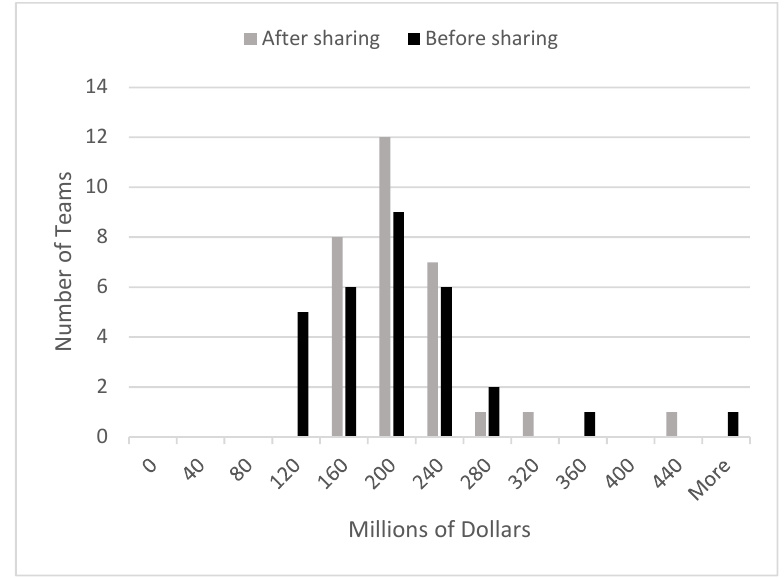
Figure 2. Local revenues pre and post-revenue sharing in MLB, 2011 season. ( R = $189.7 million, = 6234.2 , = 2968.1, σ 3 = 36,153,429, σ 3 = 5,053,763, σ 4 = 166,465,178, σ 4 = 93,707,469). Sources: Post-revenue sharing data taken from Rodney Fort’s Sports Economics website, https://sites.google.com/site/rodswebpages/codes. Pre­revenue sharing data based on author’s